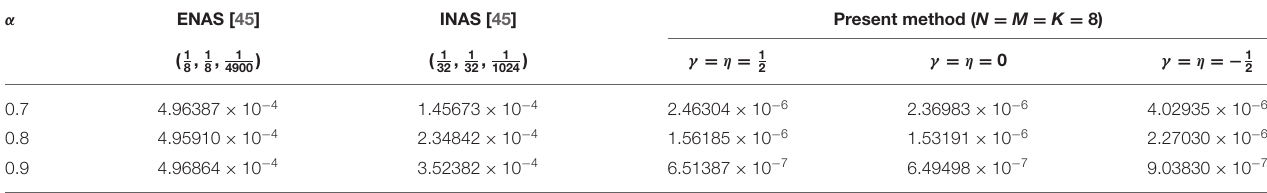
TABLE 4 | The L ∞ - errors for Example 5.2 with ω ( ν ) = δ ( ν − 1 + α ). α ENAS [45] INAS [45]